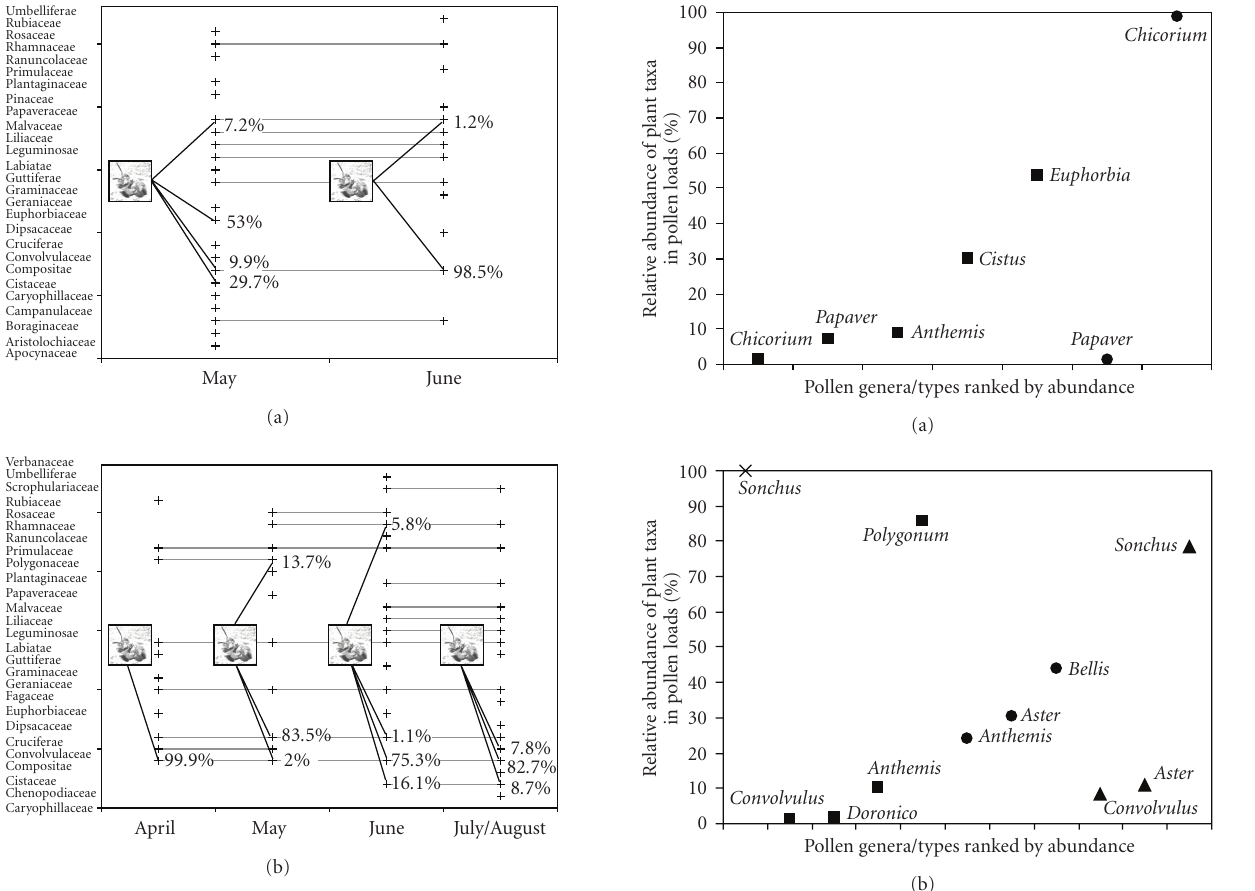
Figure 1: Presence/absence of plant families sampled in the environment and in bee pollen loads (with associated the relative abundance) (indicated by a line to a bee picture) through the period of collection. (a) Site A (wood site). (b) Site B (crop site). For bees, only families with abundance > 1% were considered.